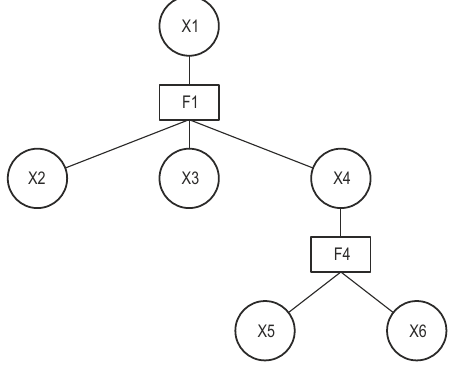
Figure 3. Example of attribute tree and utility function (source: adapted from Bohanec and Rajkovič, 1990, p.